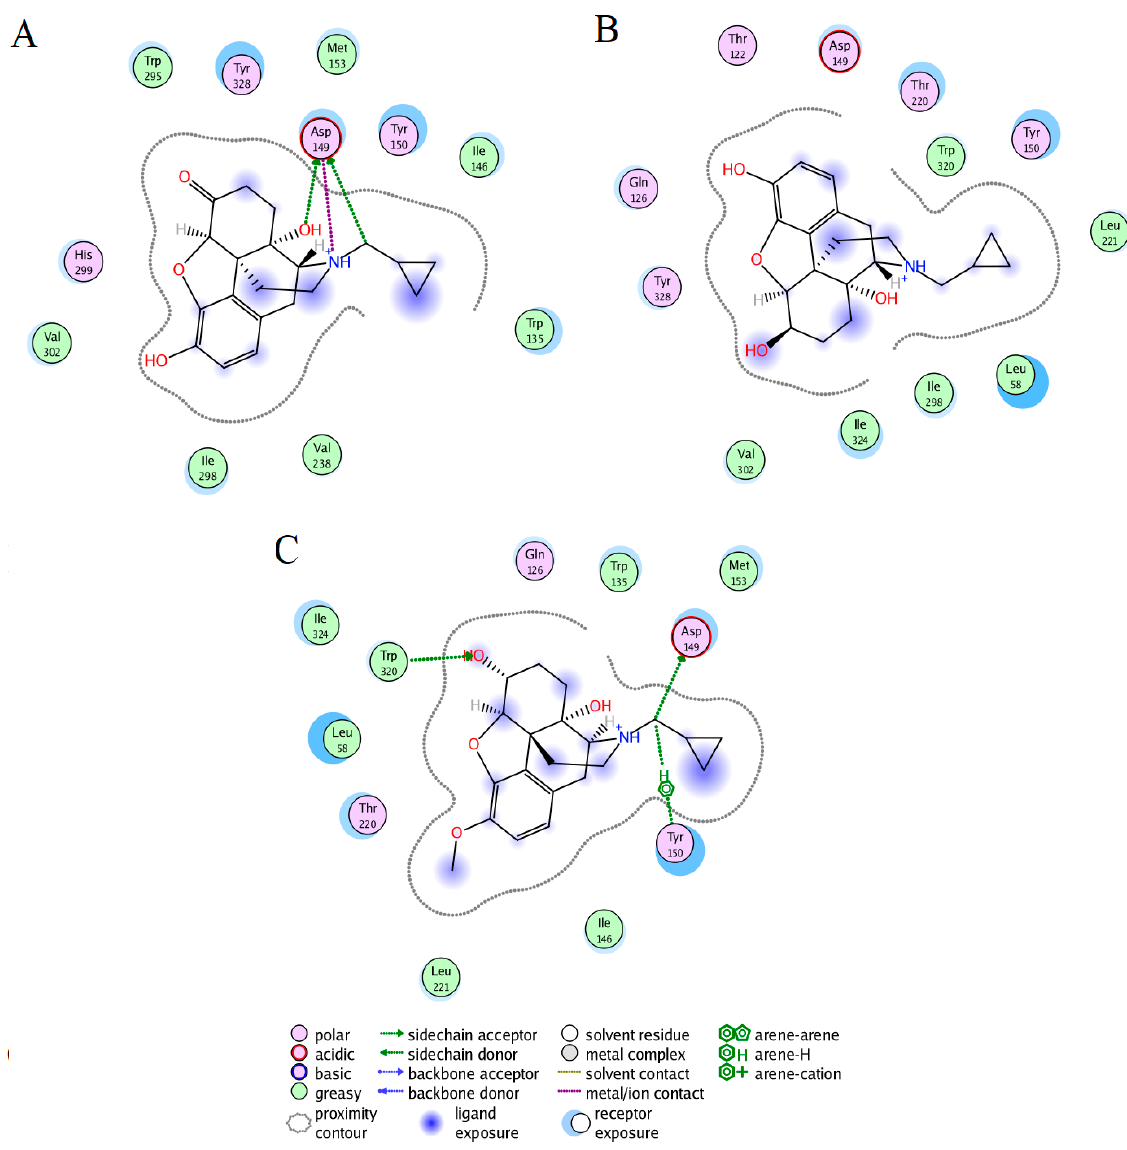
Figure 1. Docking interactions of naltrexone, NTXOL, or HMNTXOL with hMOR. Interactions of naltrexone ( A ), NTXOL ( B ), or HMNTXOL ( C ) with hMOR.